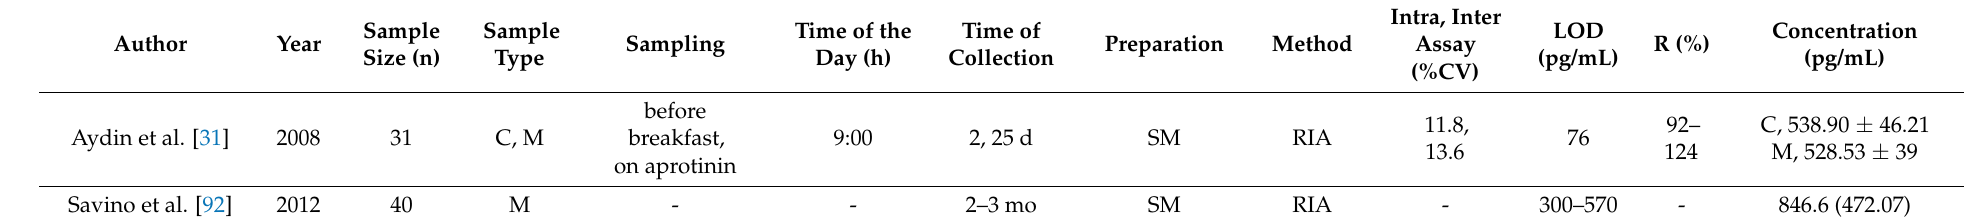
Table 6. Studies examining human milk obestatin.